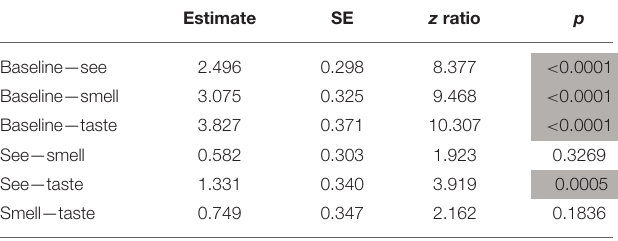
TABLE 5B | Narrator’s opinion responses: pairwise comparisons for Experiment 3.